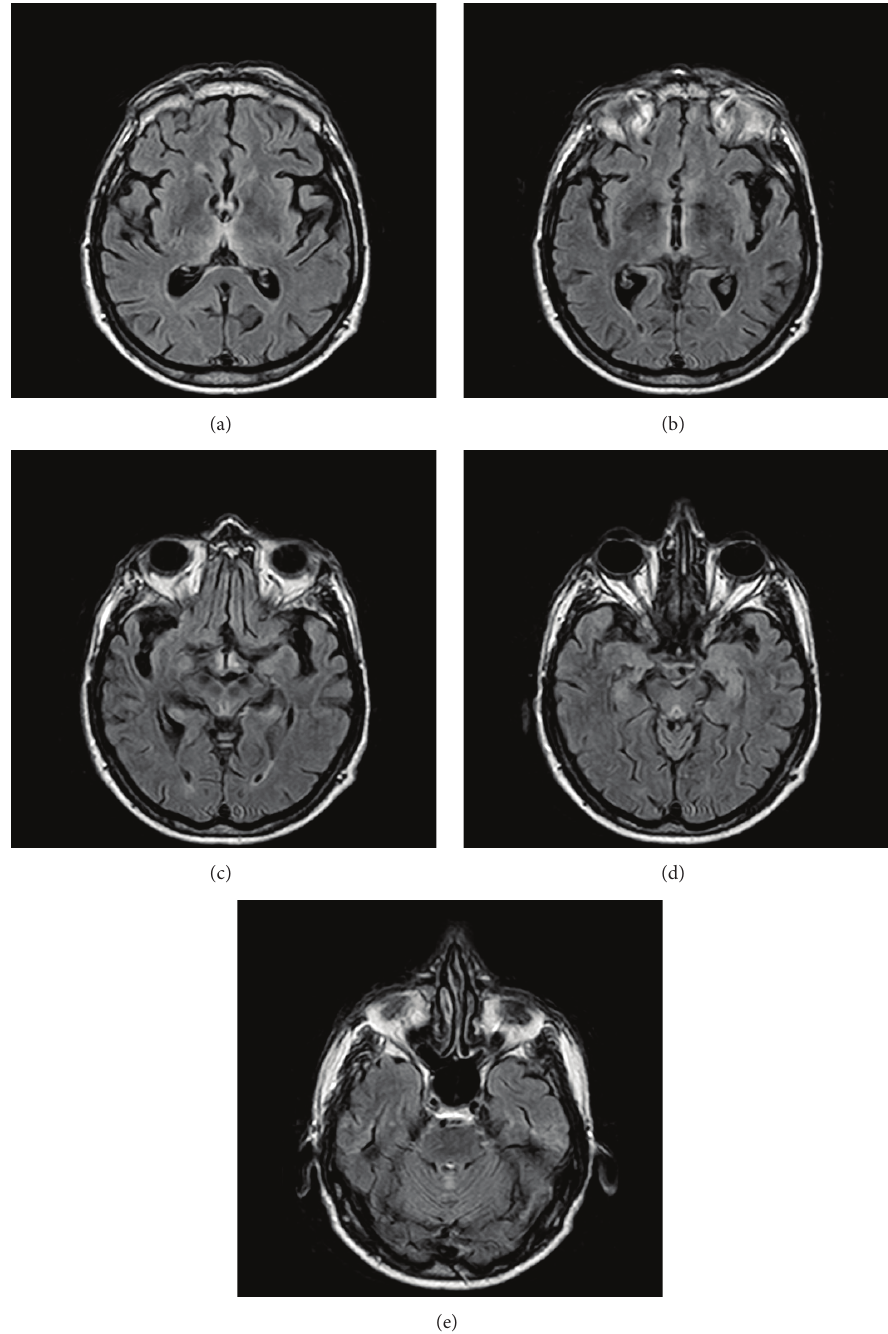
Figure1:FLAIRaxialimagesofMRIshowhyperintensityin(a)themedialregionofbilateralthalamus,(b)subependymalgreymatteraround the third ventricle, (c) third ventricle floor and periaqueductal region, (d) periaqueductal grey matter, and (e) upper cerebellar